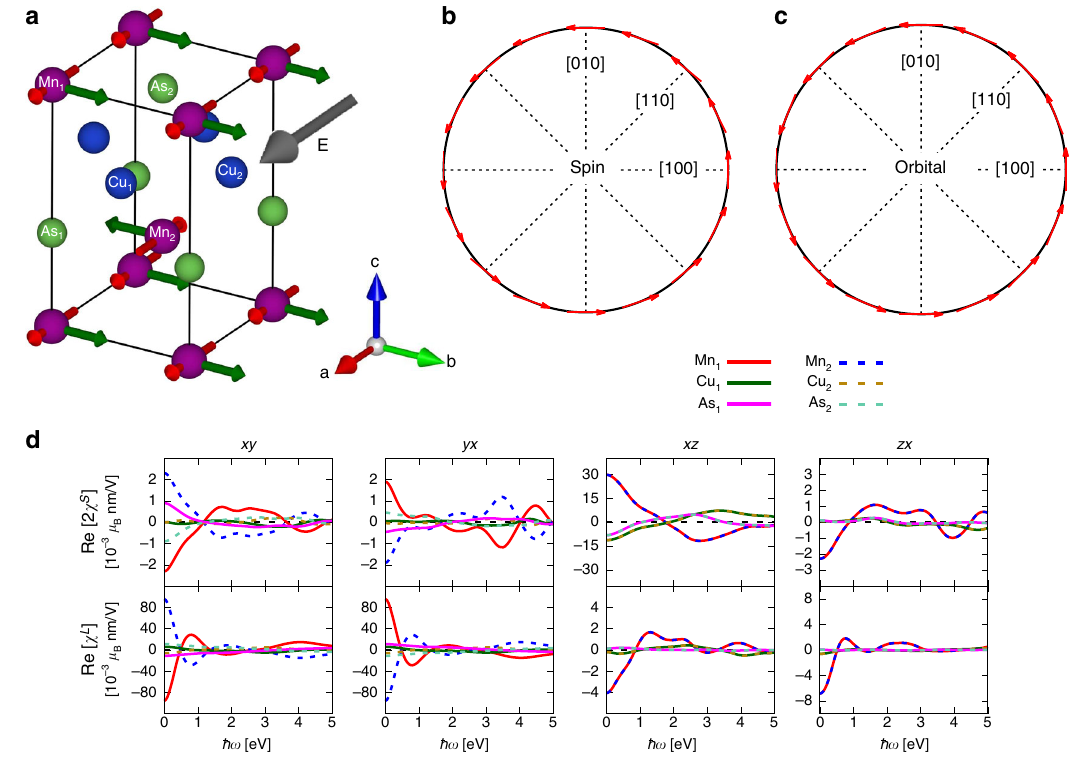
Fig. 2 Rashba-Edelstein effect in CuMnAs with magnetic moments along the a -axis. a Sketch of the tetragonal unit cell of CuMnAs. The red arrows on the Mn atoms represent the initial magnetic moments. Applying an electric fi eld E along the (100) direction (gray arrow) induces a nonequilibrium magnetization mainly along the (010) direction (green arrows). b In-plane symmetry of the induced spin magnetization as a function of the static electric- fi eld direction for Mn 1 . c In-plane symmetry of the induced orbital magnetization as a function of the static electric- the nonzero components ij ( i ; j ¼ x , y , or z ) of the spin and orbital Rashba-Edelstein susceptibility tensors, Re ½ 2 χ S (cid:5) and Re ½ χ L (cid:5) , as function of the driving electric- fi eld frequency, _ ω